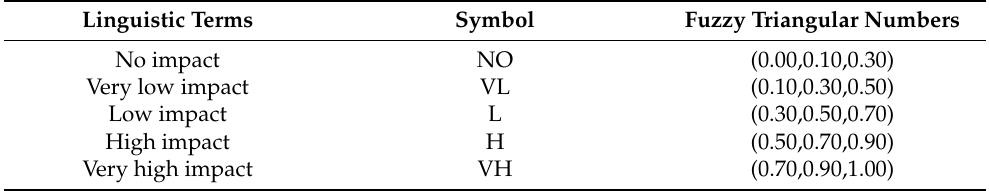
Table 2. Fuzzy triangular numbers used in FDEMATEL